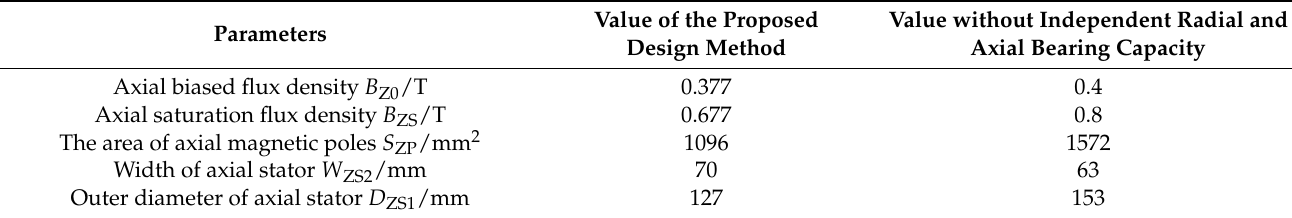
Table 2. Parameters of axial stator.